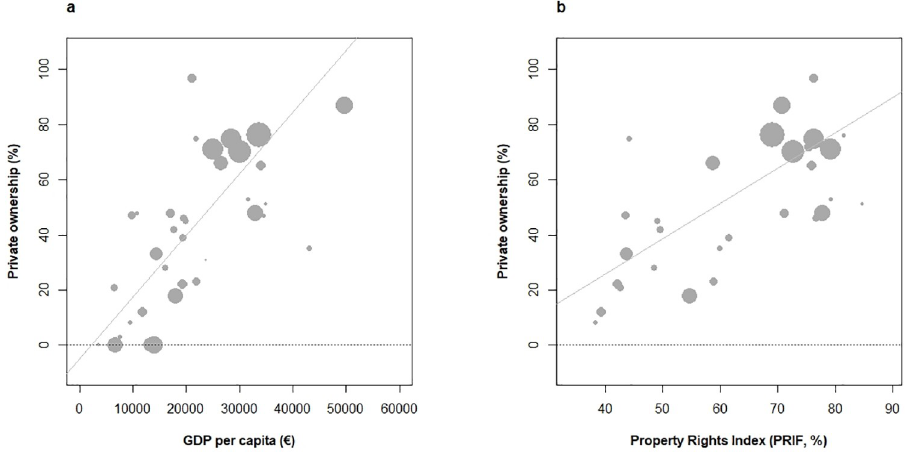
Fig 5. Relationships between private forest ownership fraction and economic richness (a) and freedom in decision making in forestry (b) across European countries under study. (a) economic development as measured by GDP.capita - 1 (GDPc, euros) in 2013 across 39 countries (b) freedom in decision making as measured by the Property Rights Index in Forestry (PRIF, [42, 43]) in 2015 and available for 30 countries (see methods). Private ownership rate in 2010. Weighted correlations (forest area in 2015): (a) +0.8 (p < 10 − 8 ) and (b) +0.71 (p < 10 − 4 ).